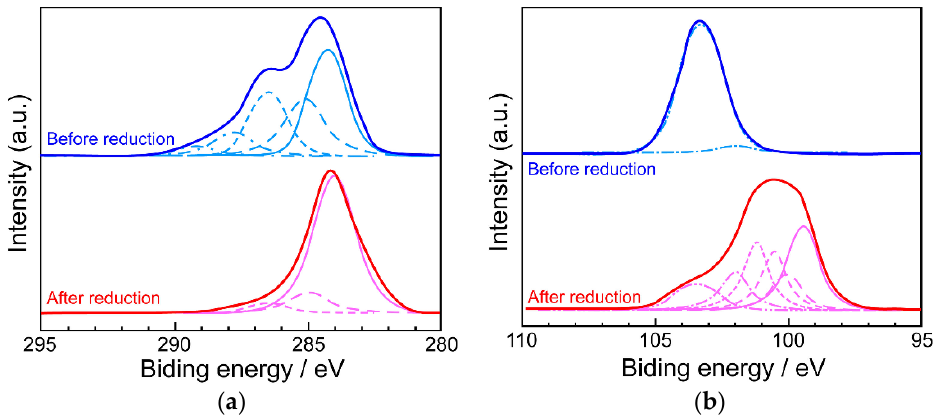
Figure 21. Raman spectra of composites before (blue) and after (red) magnesiothermic reduction.